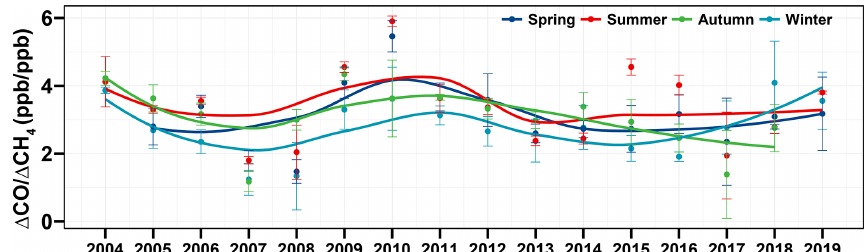
Figure 9. The long-term trend of (cid:49) CO /(cid:49) CH 4 slopes over 2004–2019 at the WLG station. The lines are the smoothed curve of the averages using the method of local polynomial regression fitting